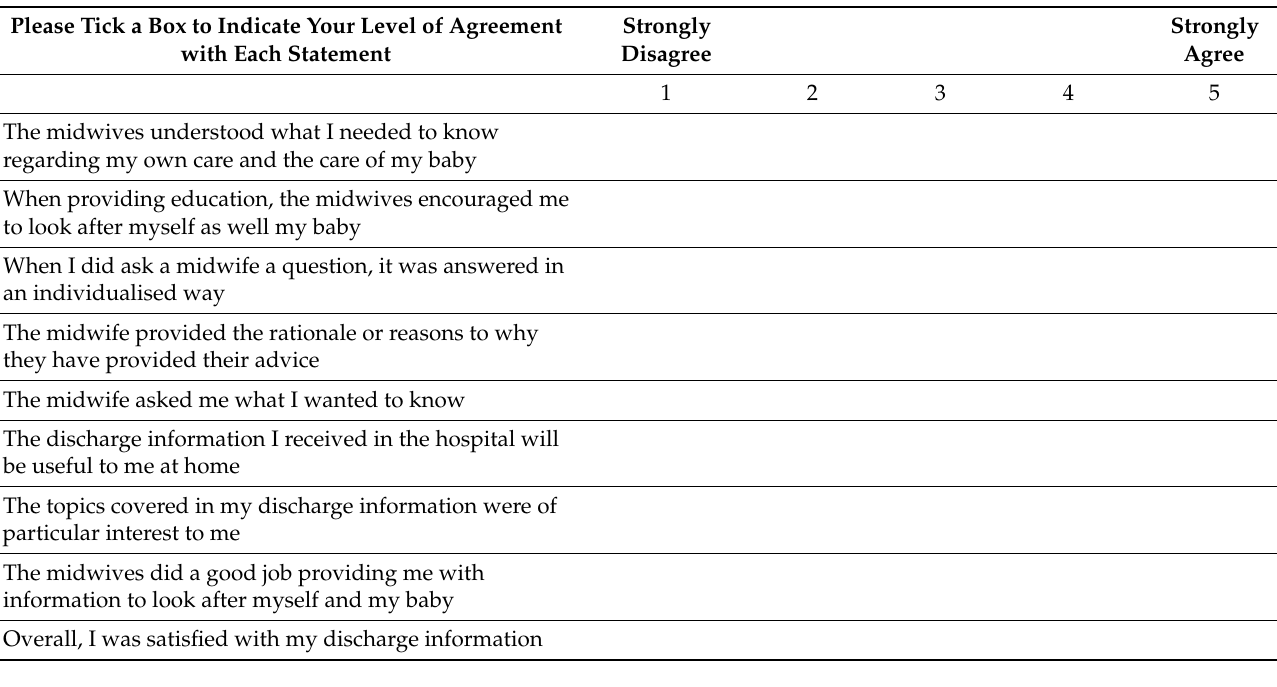
Table A1. Survey questions (example).